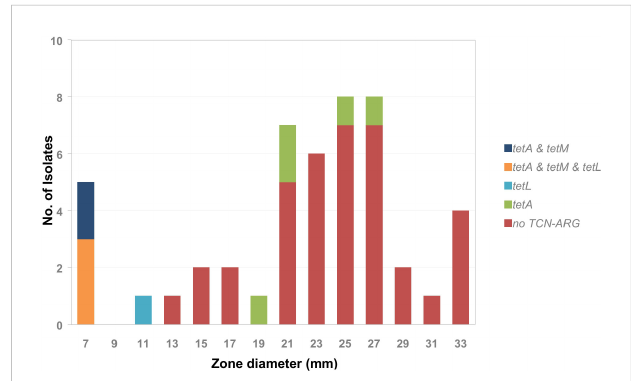
FIGURE 7 Frequency distribution of tetracycline resistance associated genes tetA , tetM , and tetL by tetracycline inhibition zone diameter within the tested A. butzleri